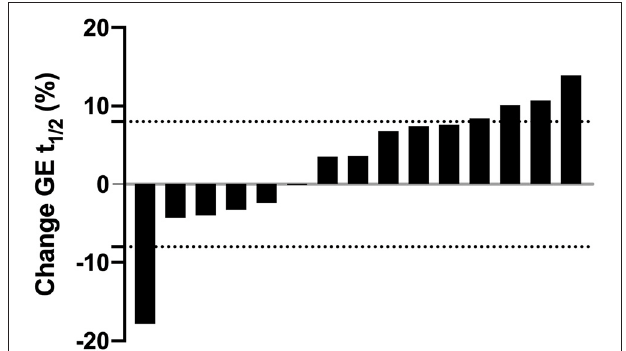
FIGURE 1 | Individual changes in gastric emptying half time (GE t 1 / 2 ) expressed as percentage change from baseline after the 4-week exercise intervention. Each bar represents an individual participant ( n = 15). Values above zero indicate a longer (i.e., slower), values below zero indicate a shorter (i.e., faster) GE t 1 / 2 after the intervention. Dashed horizontal lines represent zones of natural variation in GE t 1 / 2 ( ± 8%) based on our previous work ( 32).